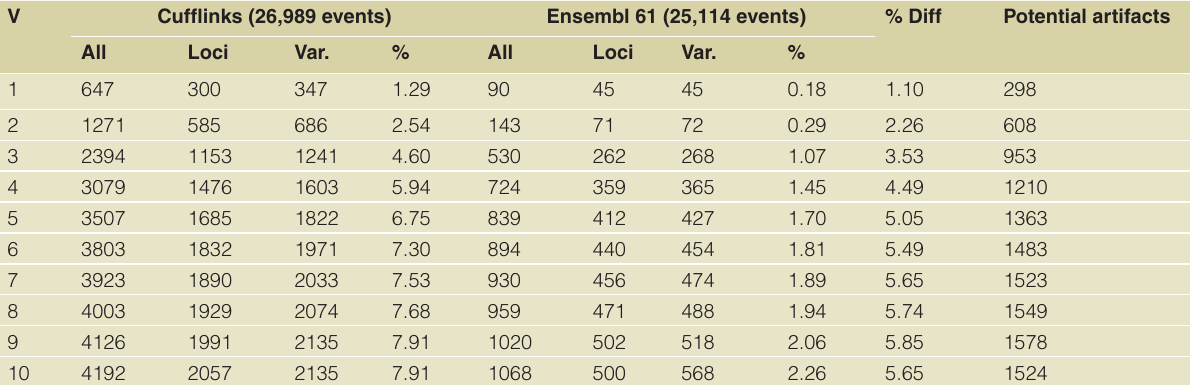
Table S6. Comparison of co-located ES events among the 26,989 events discovered from the Illumina Human Body Map data and the 25,114 exon skipping (ES) events extracted from the Ensembl v.61 annotations. All – all events co-located within V bp; Loci – clusters of co-located events (each with a representative ‘anchor’); Var (=All-Loci) – variations (not including ‘anchors’), representing potential mapping artifacts.